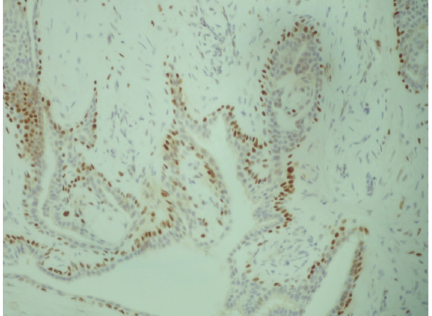
Figure 1: The lesion in the left medial canthus.